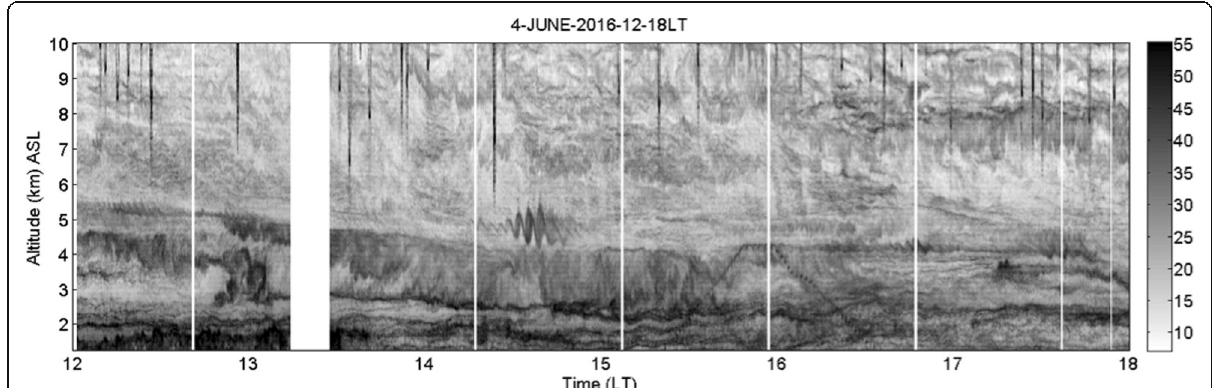
Fig. 4 As in Fig. 1 but from 12:00 to 18:00 LT on June 4, 2016 during the ShUREX 2016 campaign. High amplitude KH billows can be seen at an altitude of around 5 km from 14:30 to 14:50 LT, inside but just above the cloud base, with MCT occurring concurrently just below the cloud base. Dark thin lines around 16:00 LT denote the UAV track. Small scale KHI activity can be seen at around 16:50 and 17:40 LT